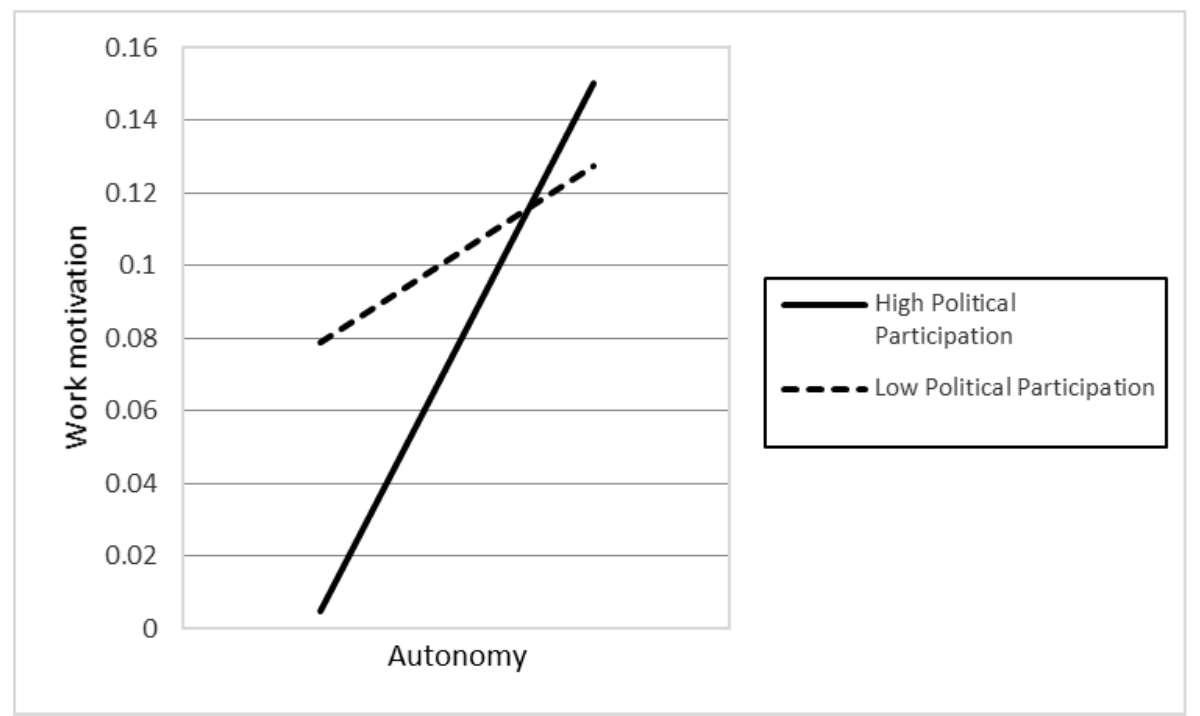
Figure 3. The association between autonomy and work motivation at different levels of political participation.